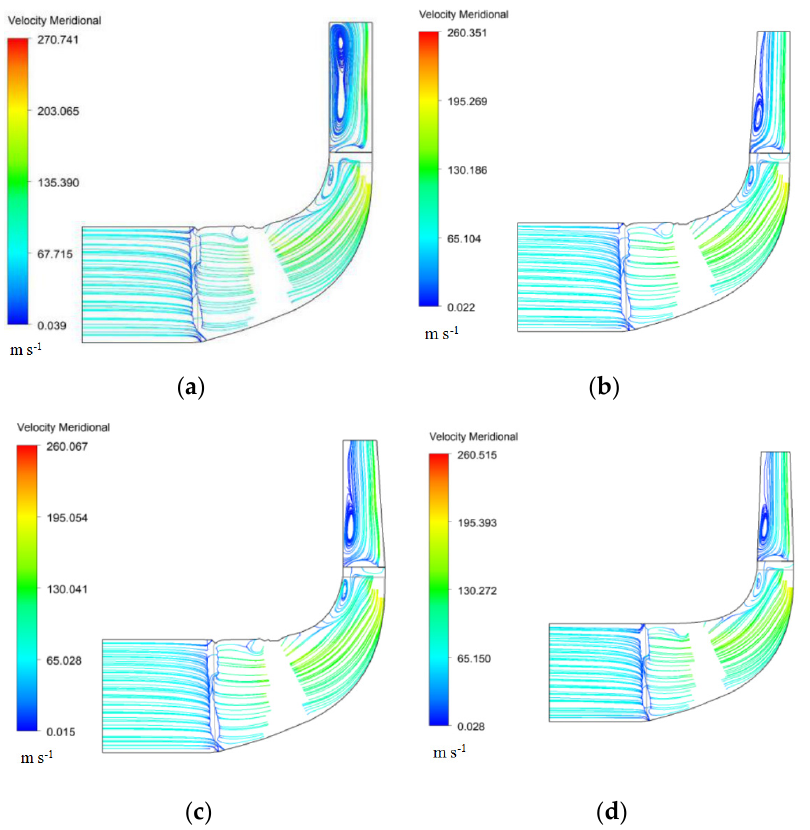
Figure 4. Radial velocity streamline distribution of the entire meridian at the design mass flow: ( a ) parallel; ( b ) convergence from shroud; ( c ) convergence from hub; ( d ) equal convergence from shroud and hub.